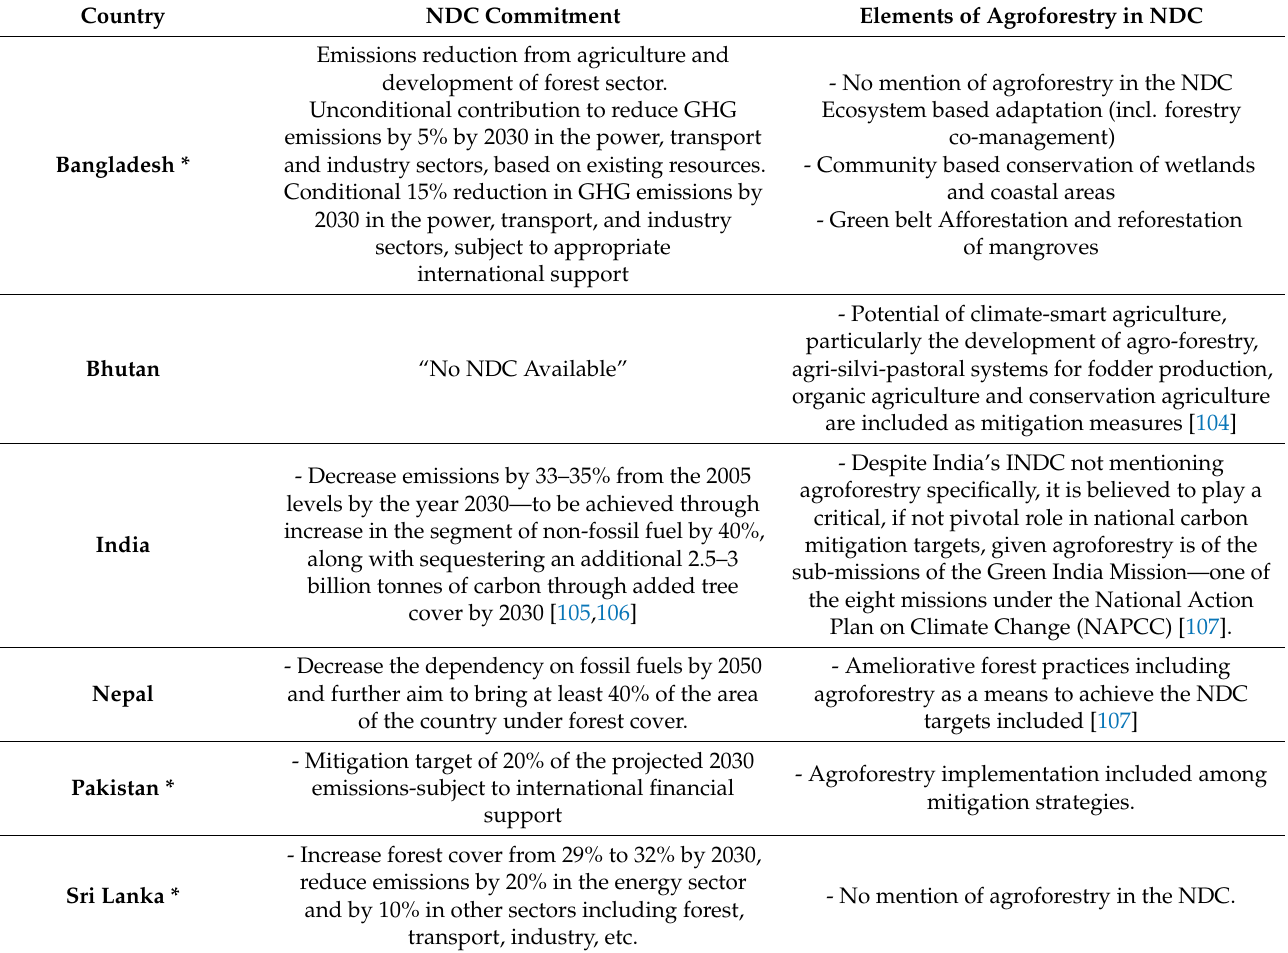
Table 5. Nationally determined contributions committed by S. Asian countries and role of agroforestry. Country NDC Commitment Elements of Agroforestry in